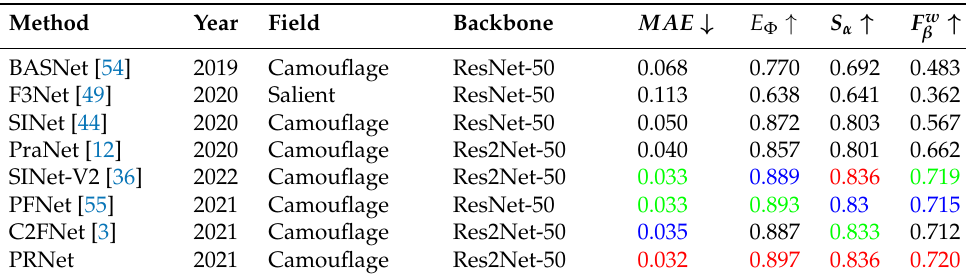
Table 2. Quantitative comparison with state-of-the-art methods for camouflaged insect detection. ↑ / ↓ indicates that larger or smaller is better. The three best results are in red, green and blue colors,